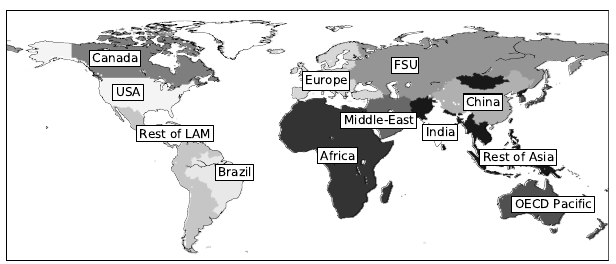
Fig. 2. Nexus Land-Use regions. OECD Pacific includes Australia, New Zealand, Japan and South Korea. FSU stands for former Soviet Union and Rest of LAM for Rest of Latin